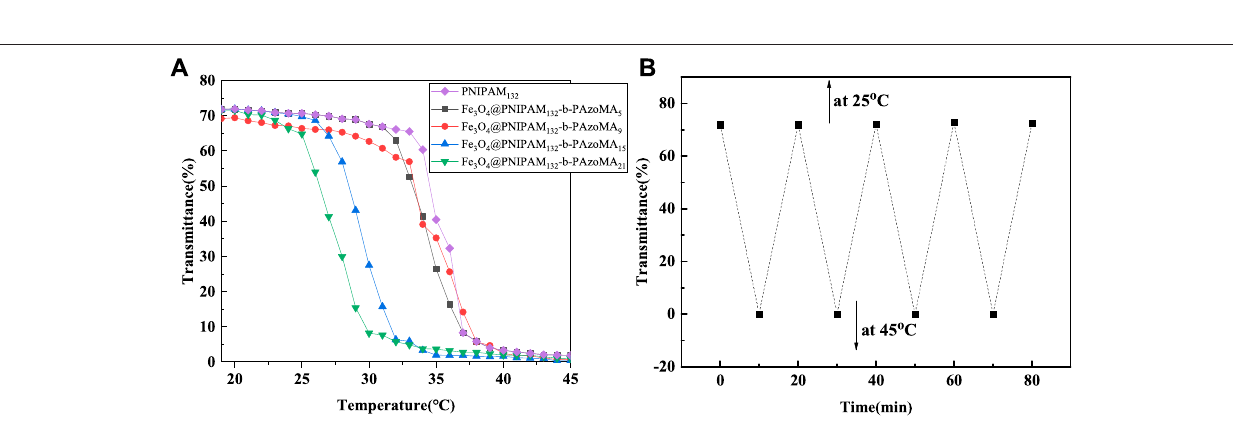
FIGURE 5 | (A) Cloud point curve for the aqueous solution of macro-CTA and Fe 3 O 4 @PNIPAM-b-PAzoMA nanoparticles. (B) Plots of optical transmittance as a function of temperature for Fe 3 O 4 @(PNIPAM-b-PAzoMA) aqueous solution with the concentration of 1 mg/ml (10 min for each temperature four heating/cooling cycles between 25 and 45 °